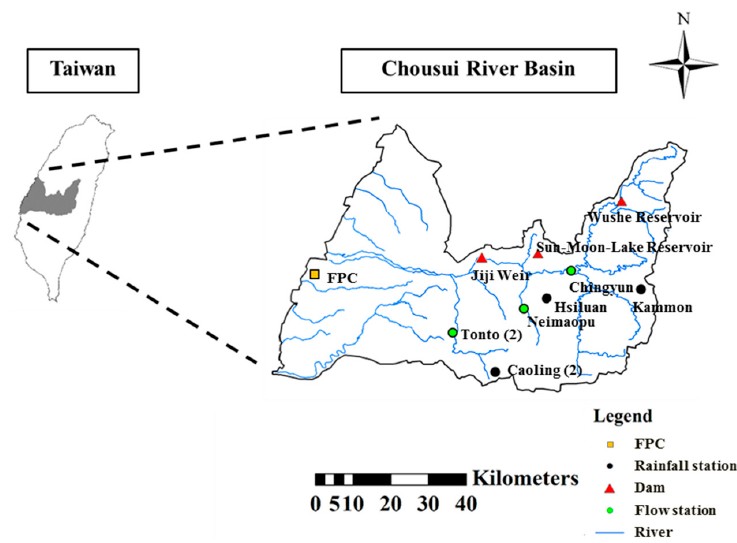
Figure 3. Location of study area, weather stations, and gauge stations.